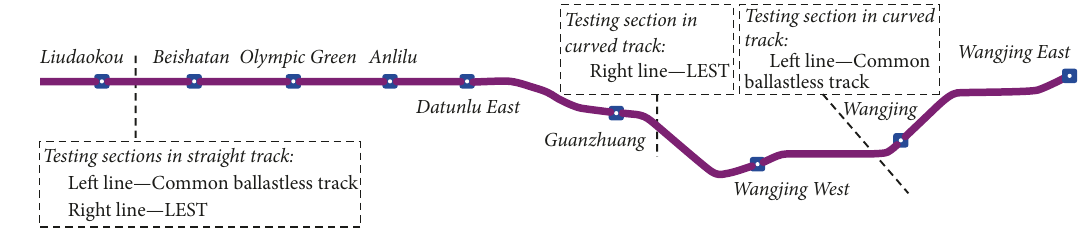
Figure 3: Distribution of test sections along Beijing Subway Line 15.